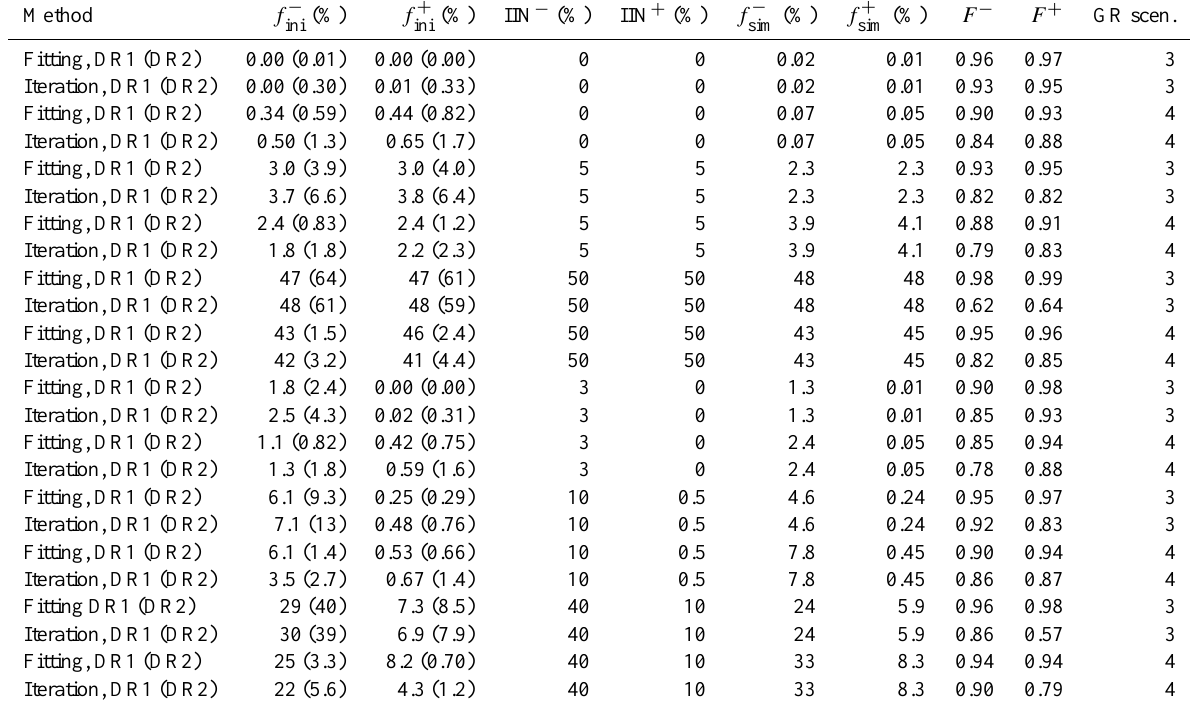
Table 5. The values of initial charged fractions determined with the fitting and the iteration methods for simulations with the values used as input in the model representing typical conditions at Hyyti¨al¨a, Finland. In these simulations, the particle growth rate (GR input ) , condensation sink and new particle formation rates were 3nmh − 1 , 1 × 10 − 3 s − 1 and 1cm − 3 s − 1 , respectively. All six combinations of fractions of IIN were used as well as GR scenarios 3 (growth rate of charged particles was moderately enhanced) and 4 (growth rate increased as a function of diameter). DR 1 and DR 2 denote the diameter ranges 1 (2.2–11.5nm) and 2 (3–11.5nm),